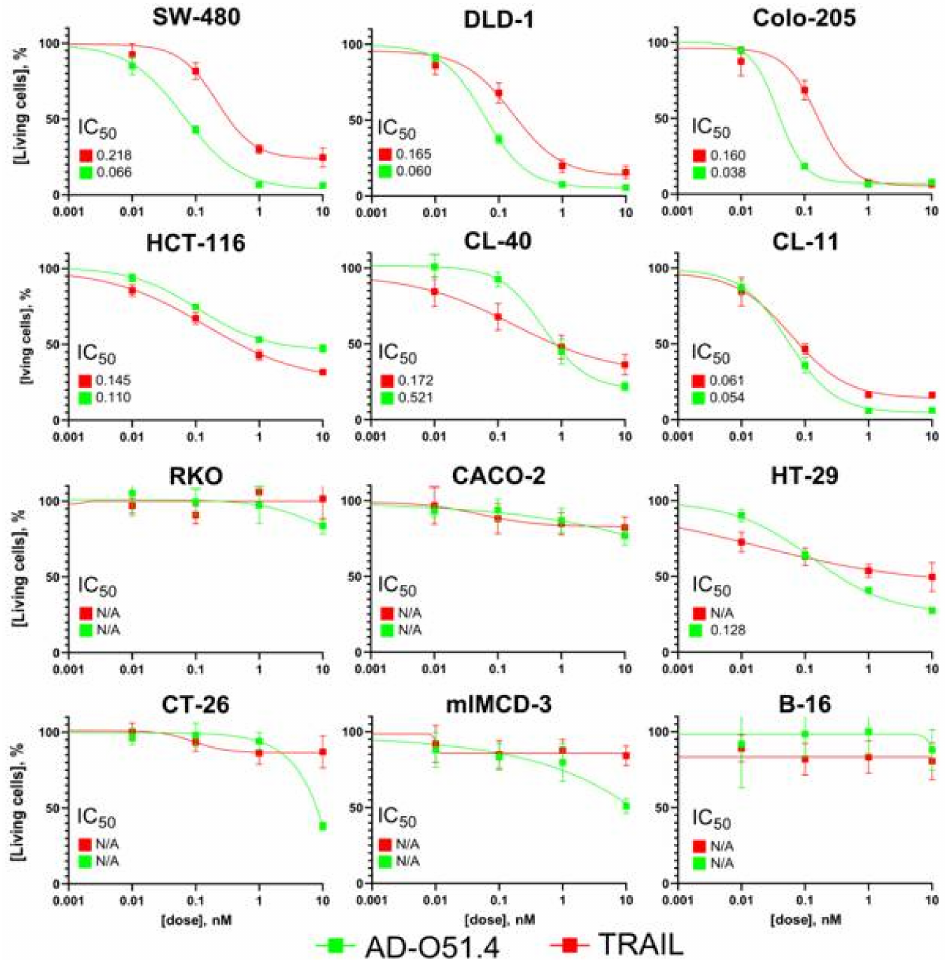
Figure 1. The dose-dependent cytotoxicity of AD-O51.4 and TNF-related apoptosis-inducing ligand (TRAIL) against colorectal cancer (CRC) and mouse (CT-26, mIMCD-3, B-16) cell lines. Results of the MTT assay showing the percentage of living cells together with the IC 50 values. Cells were seeded at 1.5 × 10 3 per well and exposed to various concentrations of the indicated agents (0.01, 0.1, 1, and 10 nM) for 48 h. Each bar represents the mean value of eight measurements in two independent experiments. Bars indicate the standard deviation. N/A: not